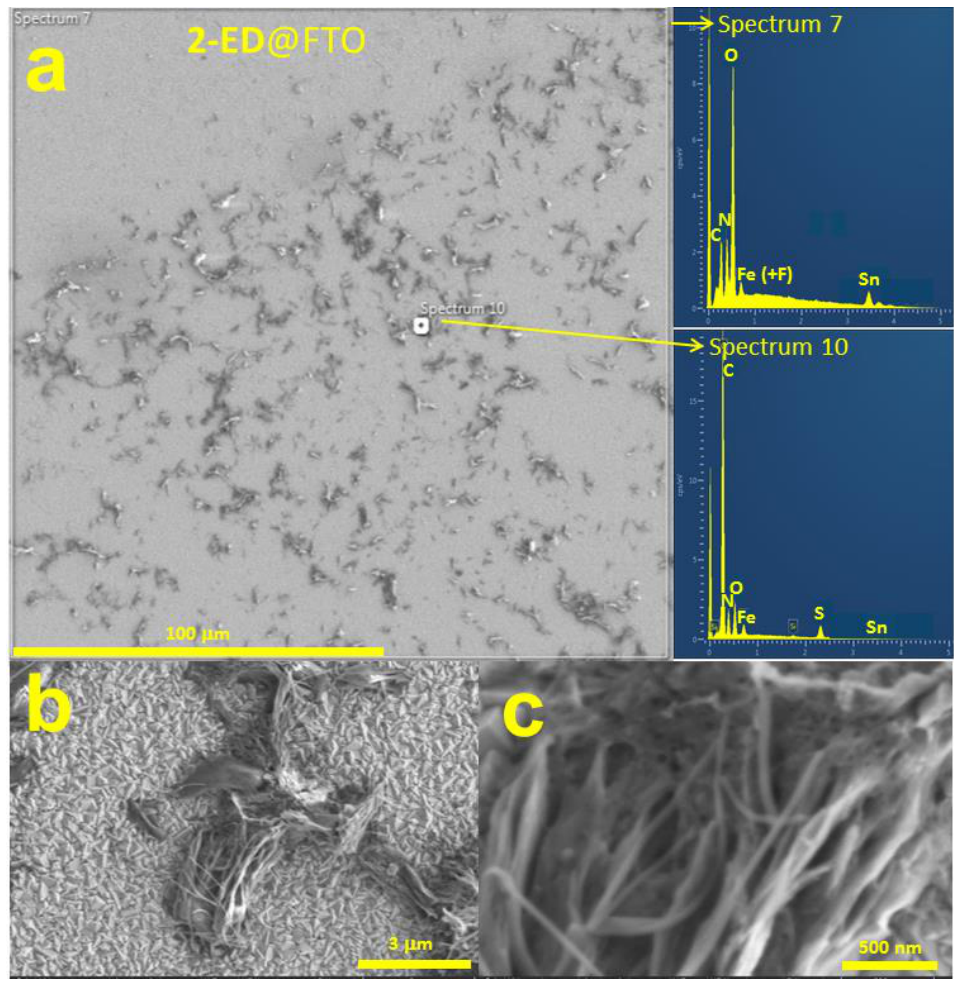
Figure 6. ( a ) SEM image at ×500 magnification of 2 -ED@FTO after 8 h of CA at +1.5 V vs . Ag/AgCl in 0.2 M borate buffer at pH 8.2, inset: EDX spectrum of the area in the white frame ((Spectrum 7, and from a small spot (Spectrum 10)); ( b ) SEM image at ×10,000; and ( c ) at ×50,000 magnification (see Figures 1 and 3d for further information on this sample).